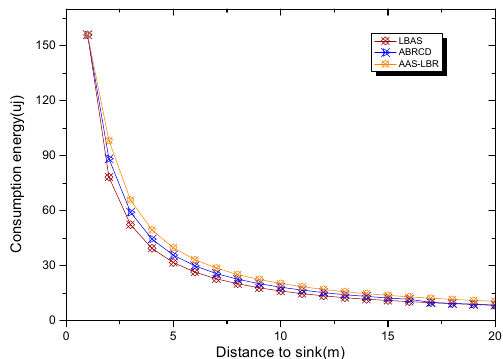
Figure 25. Energy consumption of nodes 1–20 m away from sink under 𝑇 = 20 and 𝑟 = 28 m .